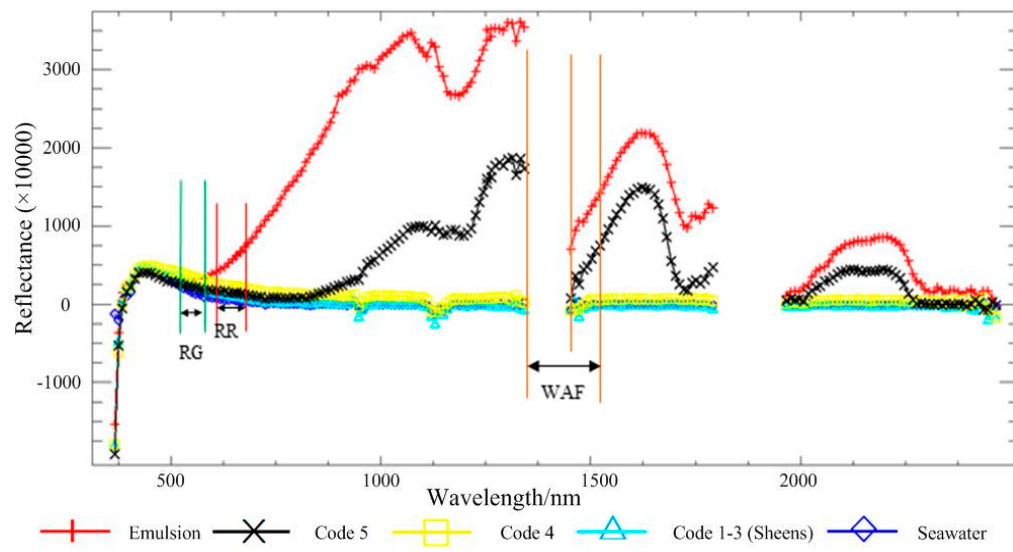
Figure 15. Bands of spectral indices used by RR, RG, and WAF. Red, black, yellow, cyan, and blue lines represent emulsions, oil slicks of code 5, oil slicks of code 4, oil slicks of code 1–3, and seawater, respectively.